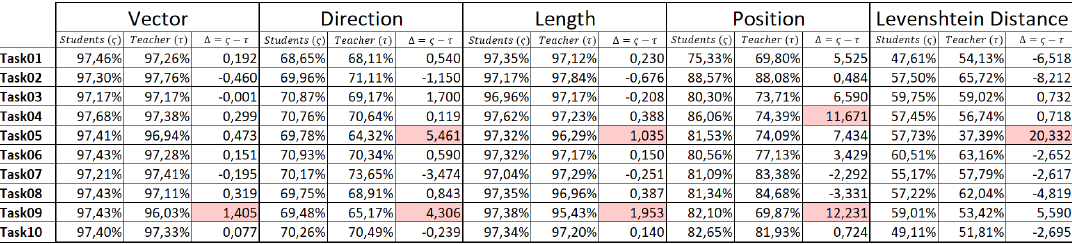
Figure 12. Results of the similarity analysis between the scanpaths of students and their geography teacher. Red values indicate a unique strategy by the teacher.